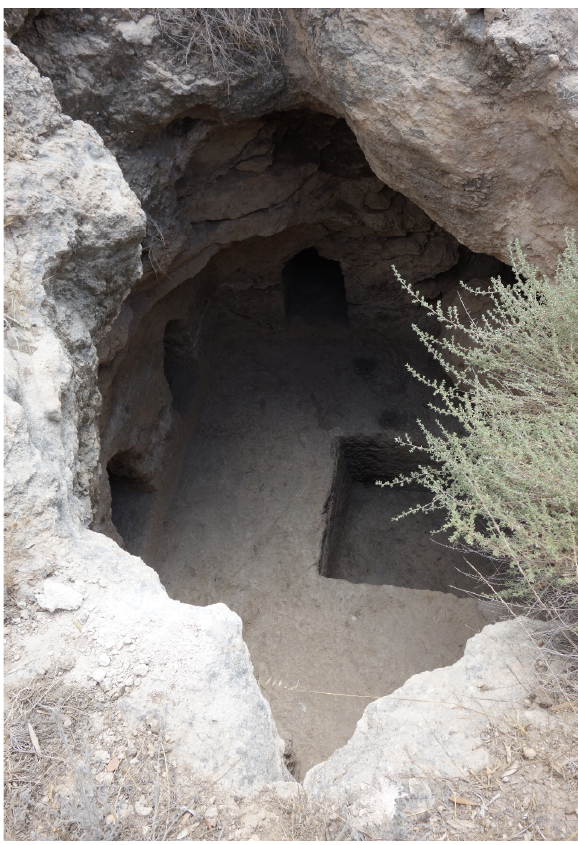
Figure 13. Openings of the burial